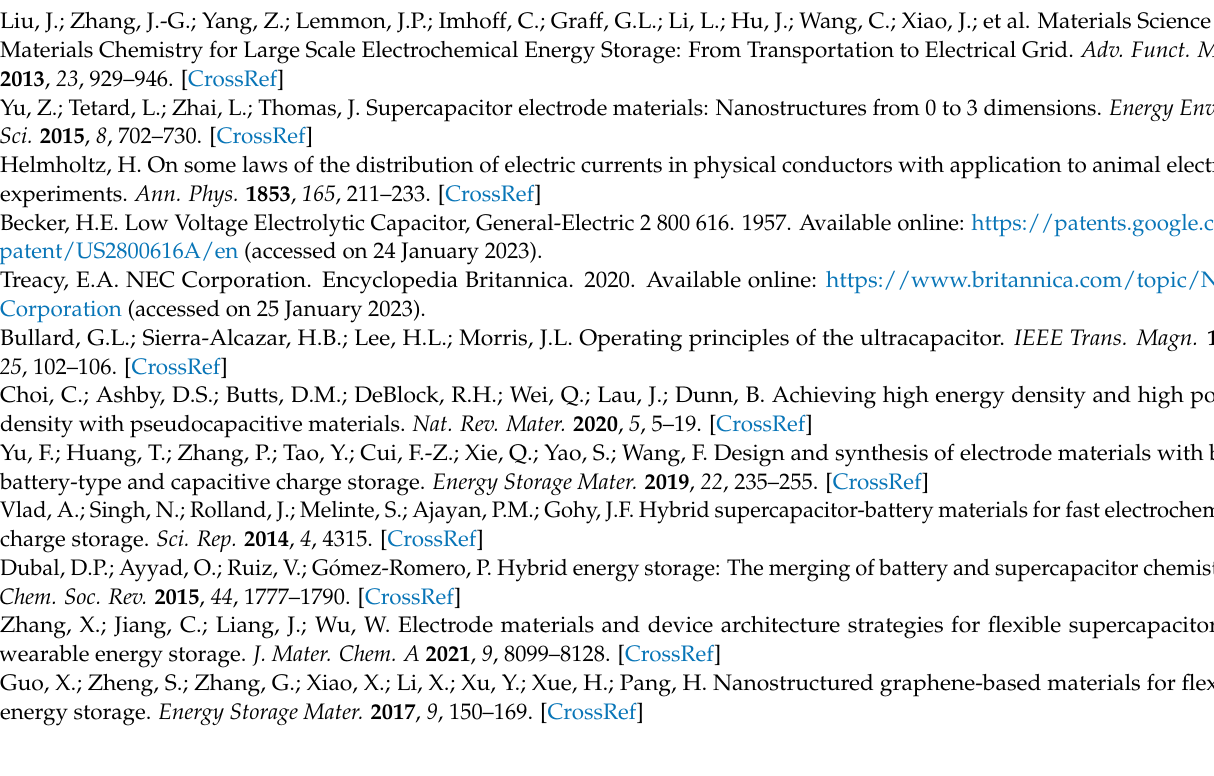
Figure 11i—Licence 1315164-1, Figure 12a,b—Licence 1315166-1, 24 January 2023; Figure 12c—Licence 1315166-2, 24 January